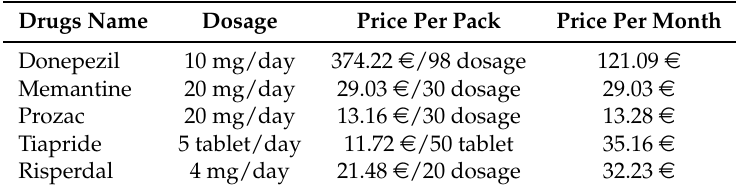
Table 2. Cost of medicines.